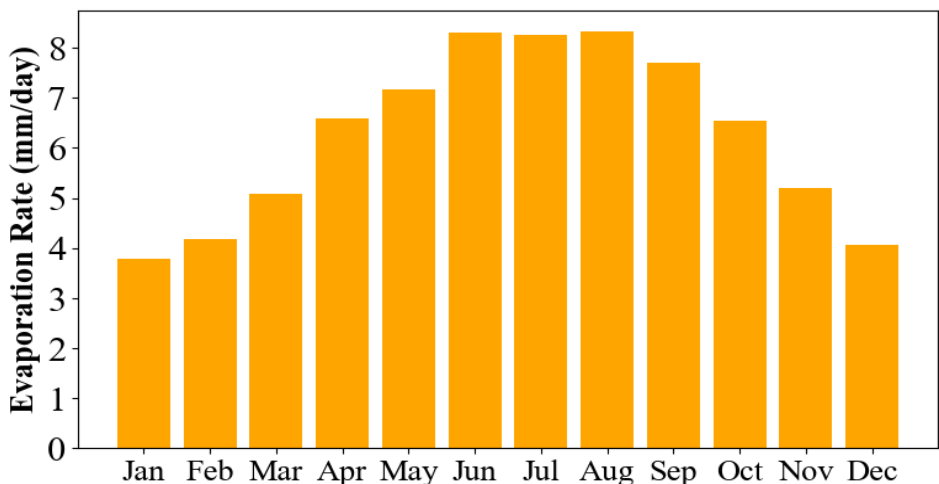
Figure 3. Average monthly evaporation rate used in the model.